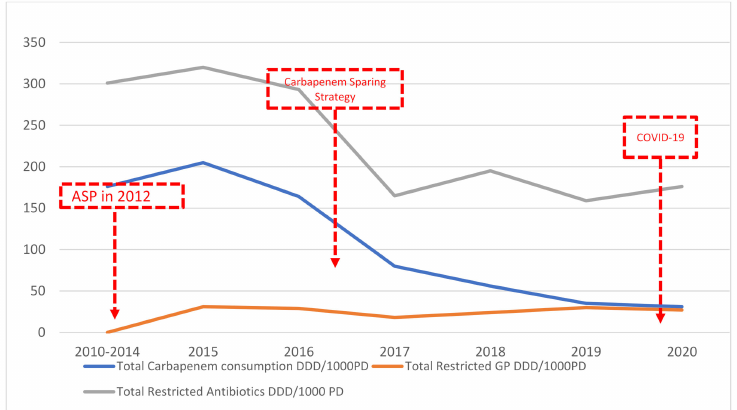
Figure 5. The restricted antimicrobial consumption calculated as daily define dose (DDD) per 1000